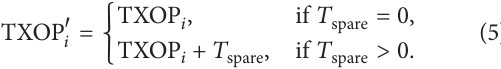
of the considered station, by modifying the related TXOP computed during the admission control, if some unused time is